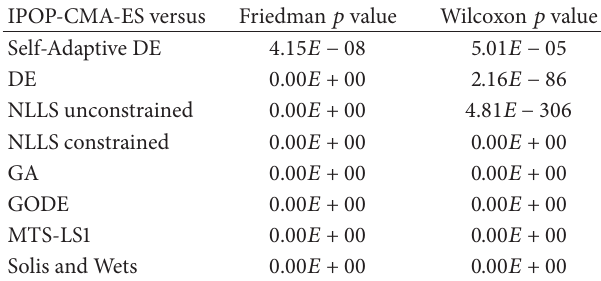
Table 18: Raw 𝑝 values (NLLS unconstrained is the control algorithm) for the 9th degree polynomial.